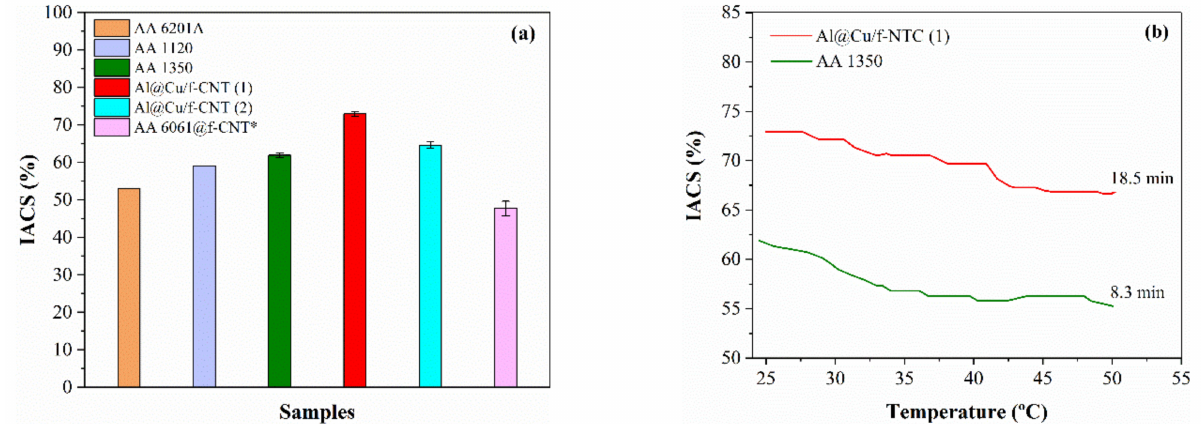
Figure 6. ( a ) Comparison between the IACS values of conventional AA 6201A, AA 1120 and AA 1350 wires with nanostructured Al@Cu/f-CNT (1), Al@Cu/f-CNT (2) and AA 6061@f-CNT wires, at room temperature. ( b ) Comparison between the IACS values of samples AA 1350 and Al@Cu/f-CNT (1) measured as a function of heating from 25 to 50 ◦ C. AA 1120 and AA 6201A values extracted from [64]. *AA6061@f-CNT values extracted from